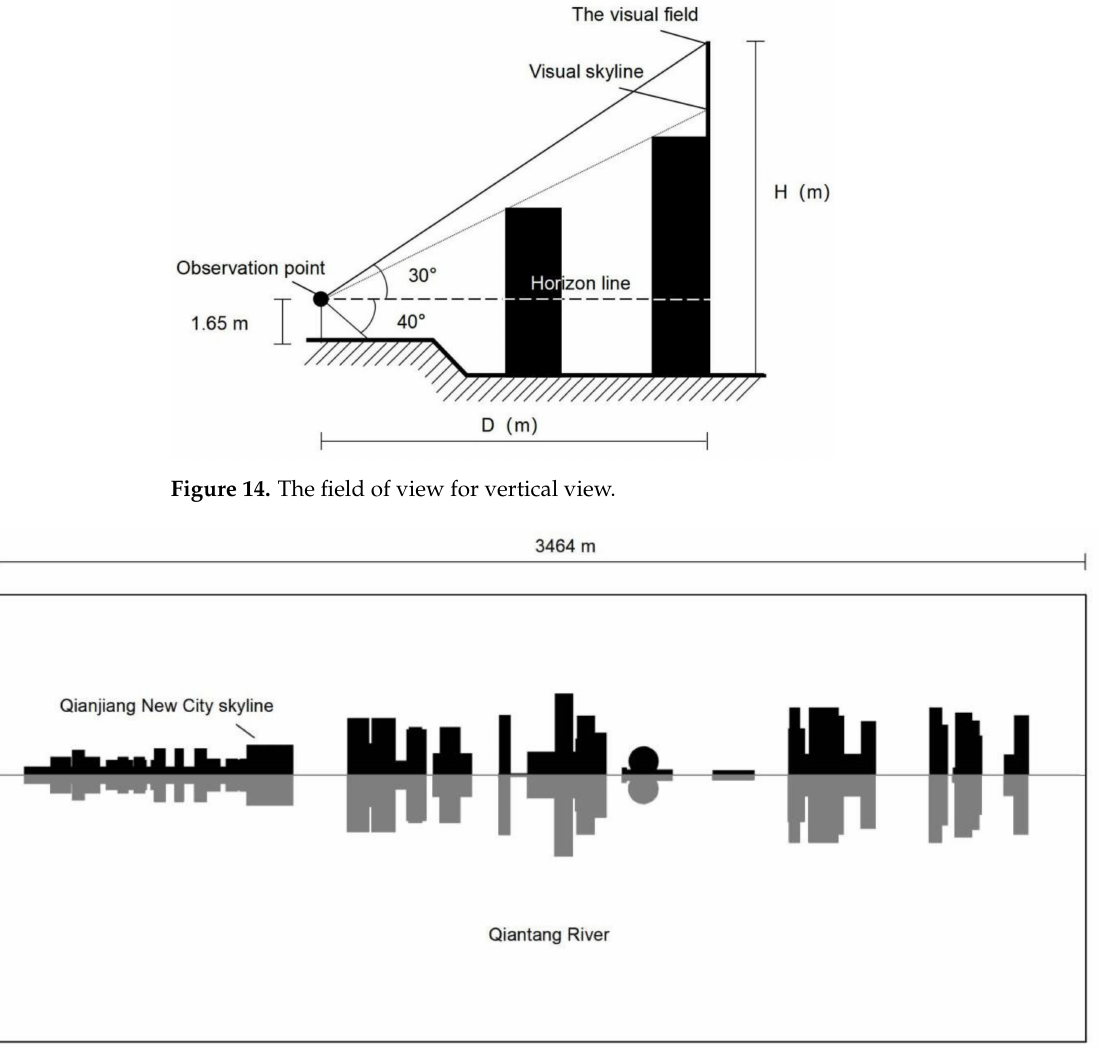
Figure 15. Hangzhou Qianjiang New City skyline’s virtual view surface.